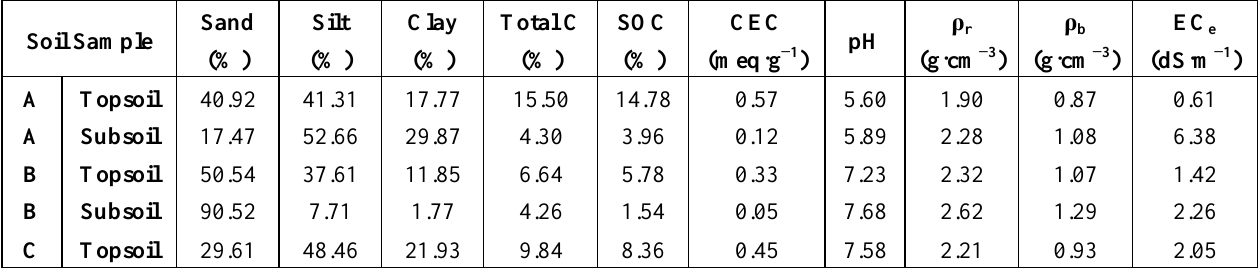
Table 1. Texture, total and organic carbon content, cation exchange capacity, pH, particle density, bulk density, and conductivity of the saturated paste extract for the five soil samples collected in the Ca’ Bianca sites and used in this